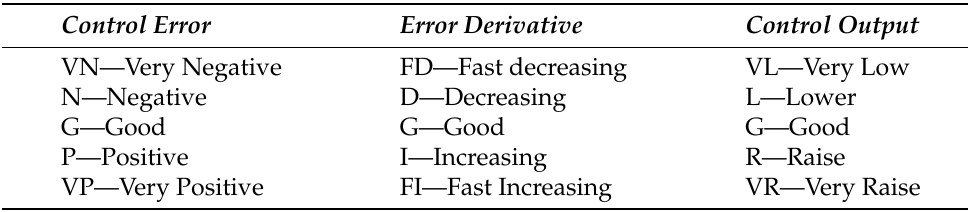
Table 1. The input and output membership functions.